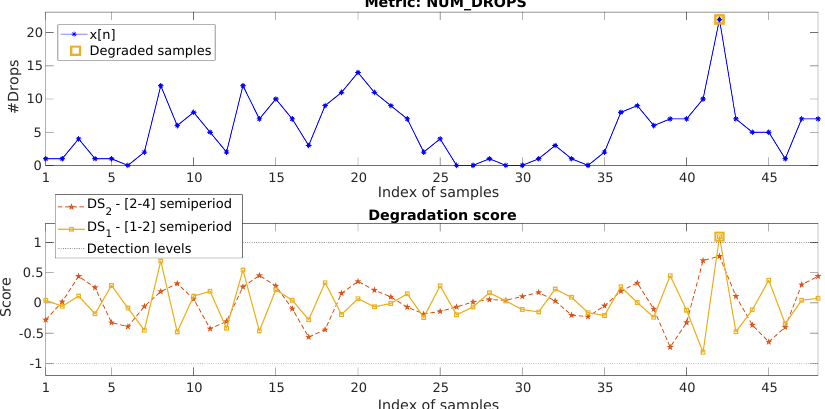
Figure 12. Two-day data of the hourly metric NUM_DROPS and its decomposition and detection process.